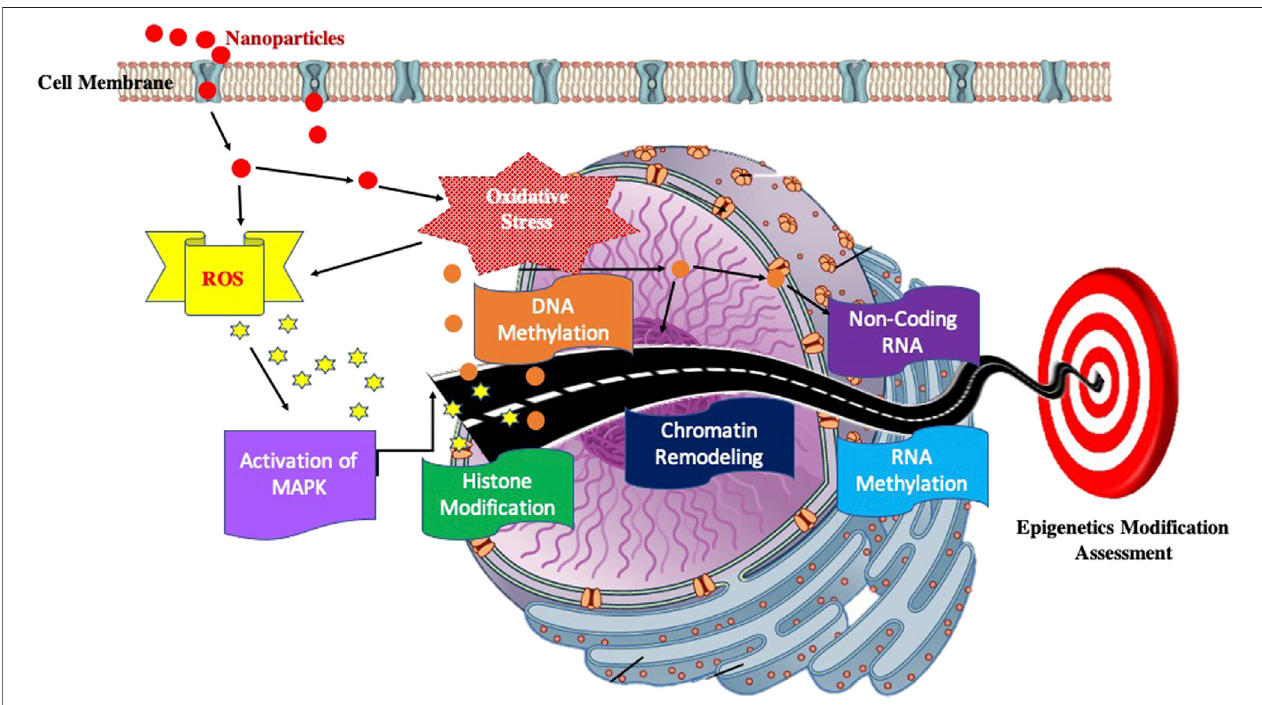
FIGURE 4 | Block diagram showing possible pathway to elucidate the Impact on